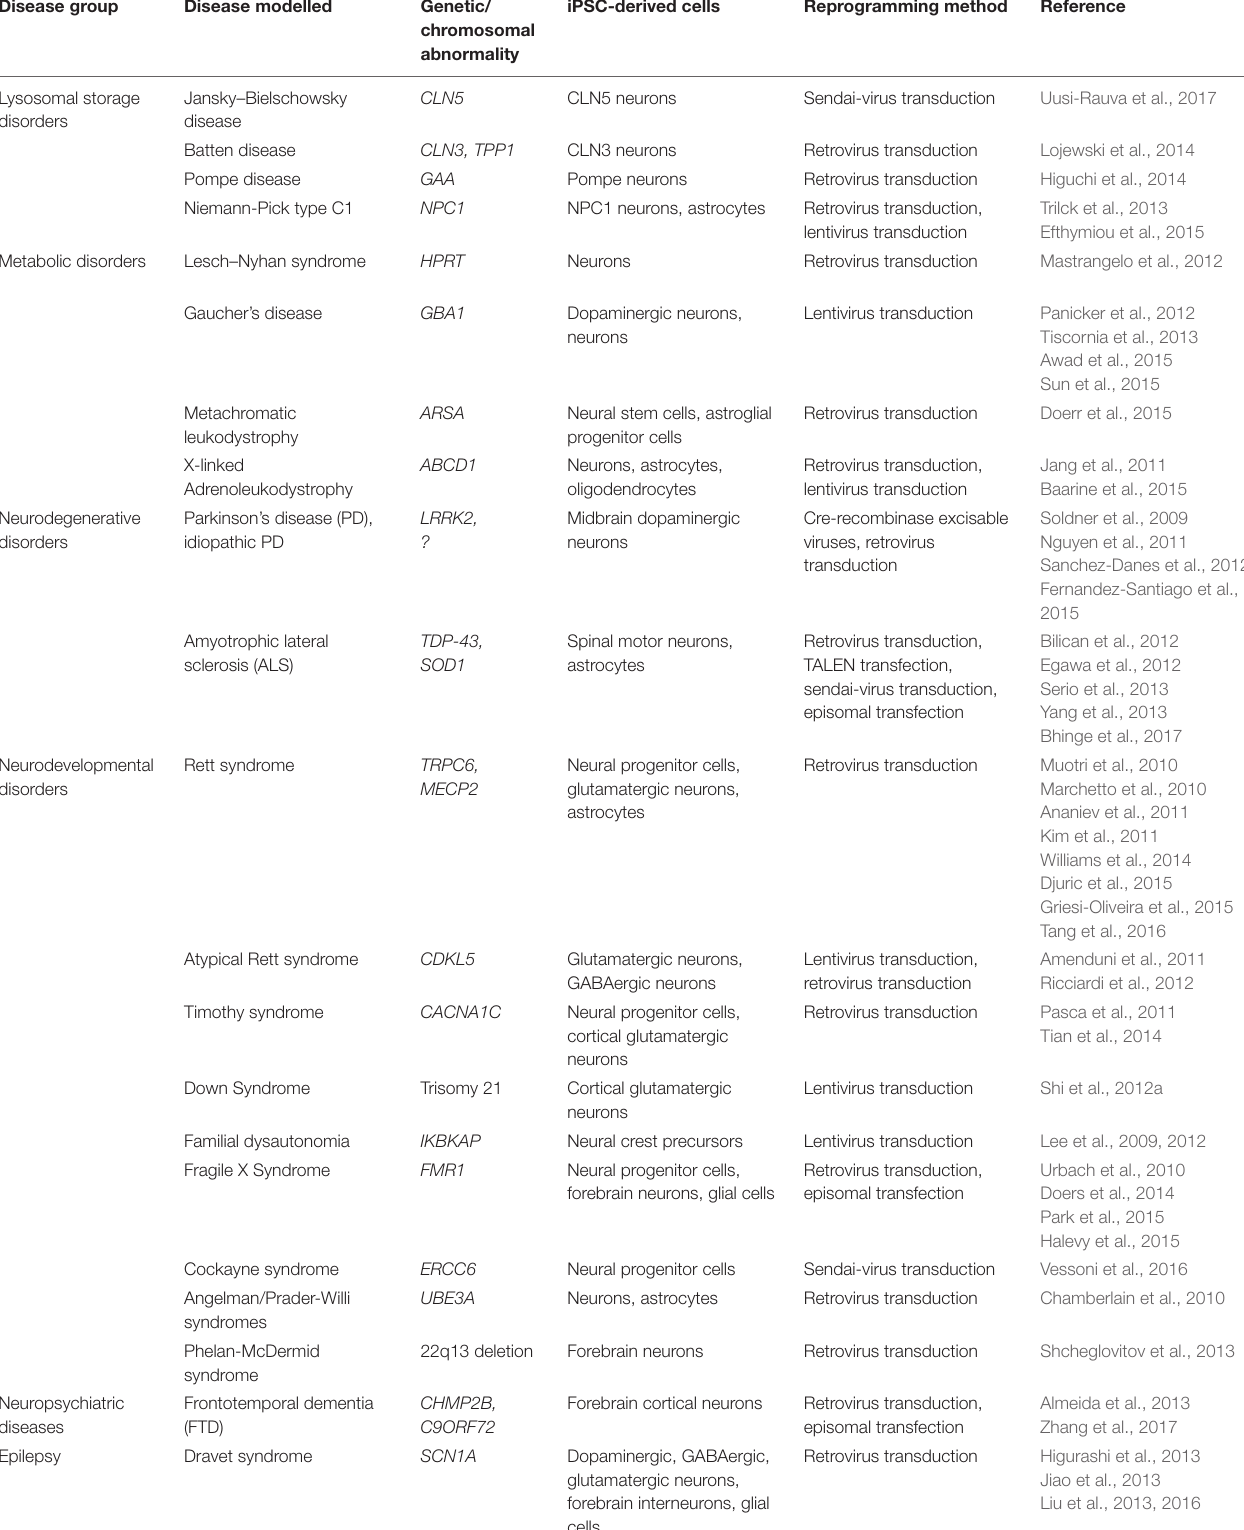
TABLE 1 | Summary of different CNS neural cells differentiated from